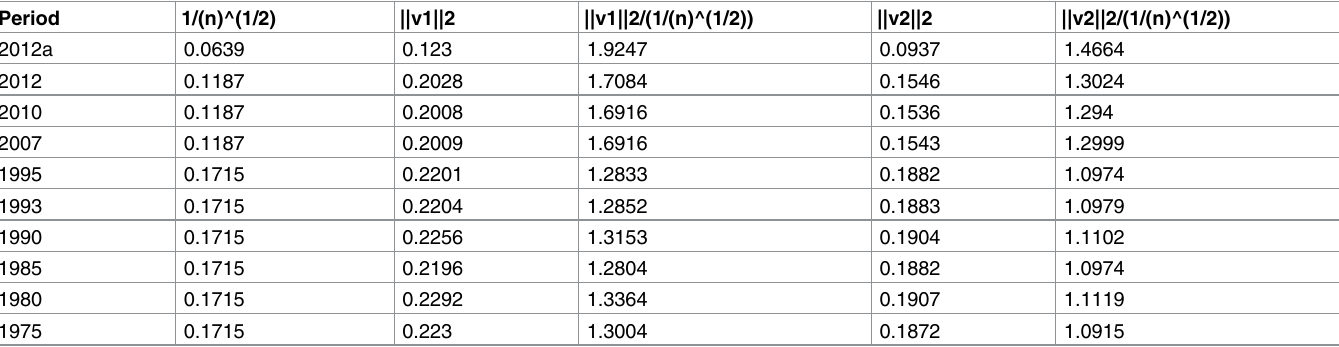
Table 4. Analysis of the impact of aggregate